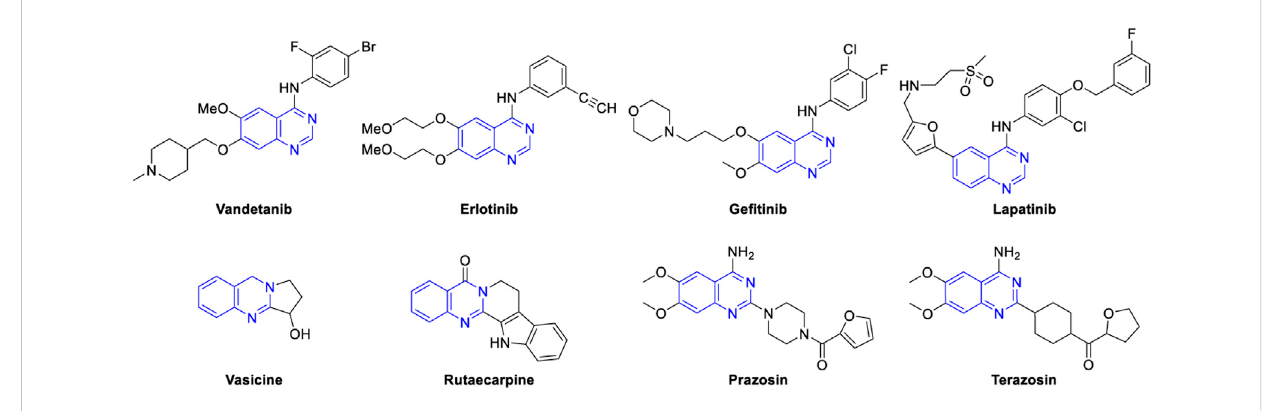
Quinazoline-containing drugs and natural products.